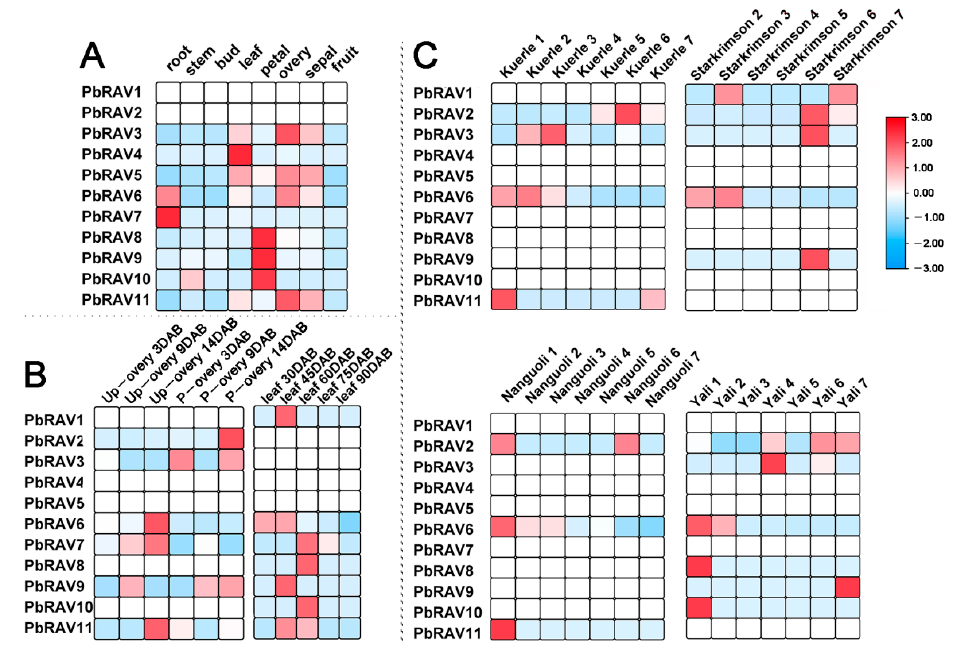
Figure 5. Expression profiles of PbRAV s in pear. ( A , B ) Expression profile of PbRAV s in different tissues ( A ) and in ovary and leaf at different development stages ( B ) of P. bretschneideri ‘Xinli No. 7.’ ( C ) Expression profile of PbRAV s at different fruit development stages in various P. bretschneideri varieties. P-ovary: pollinated ovary; Up-ovary: unpollinated ovary.